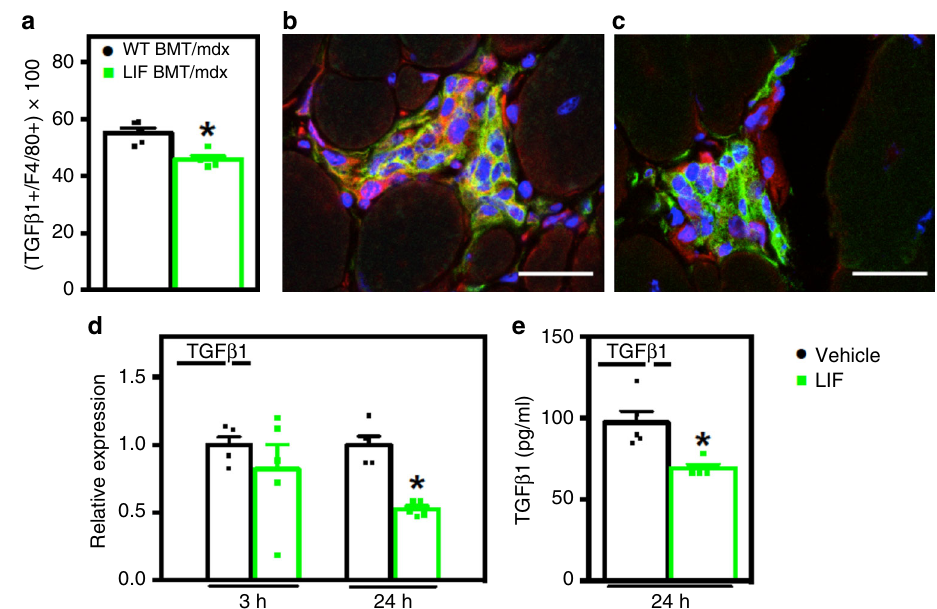
Fig. 6 LIF inhibits macrophage TGF β 1 expression. a – c Muscle sections were co-labeled with antibodies to pro- fi brotic TGF β (red) and the pan macrophage marker F4/80 (green) to test for changes in macrophage expression of TGF β . Nuclei appear blue (DAPI). Bars = 25 μ m. a The proportion of F4/80 + cells co-expressing TGF β was reduced in LIF BMT/ mdx recipients. The greatest reduction in the number of F4/80 + cells positive for TGF β (orange) was in in fl ammatory lesions of LIF BMT/ mdx ( c ) compared to WT BMT/ mdx recipients ( b ). N = 5 for each data set, * indicates signi fi cantly different from WT BMT/ mdx recipients at P < 0.05. For all histograms in the fi gure, the bars indicate mean ± sem. d QPCR analysis of BMDMs treated with recombinant LIF (10 ng/ml) for 3- or 24-h shows that Tgfb1 expression is inhibited by LIF after 24 h of stimulation. e The concentration of secreted TGF β was also reduced in BMDMs stimulated with LIF for 24 h, analyzed by ELISA. N = 5 technical replicates for each data set. Signi fi cant fi ndings were veri fi ed with biological replicates of experiments from independent donors. * Indicates signi fi cantly different from control at P < 0.05. Source data are provided as a